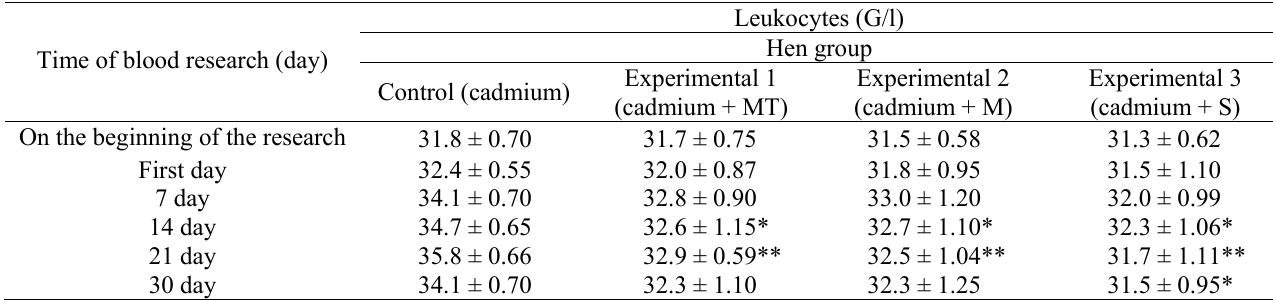
Time of blood research